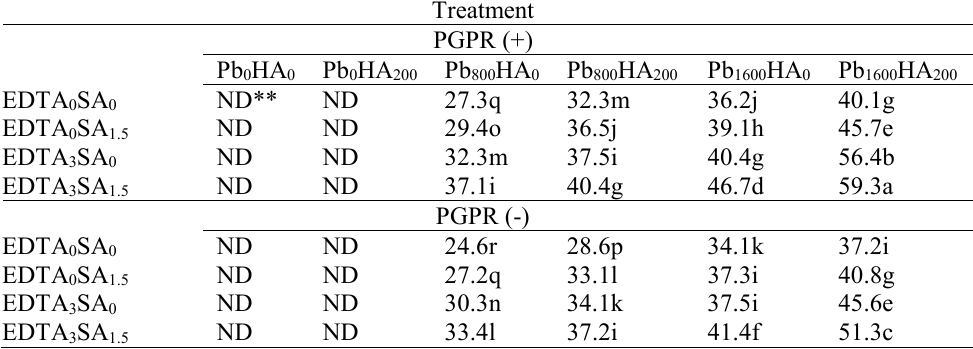
Table 4. Effect of treatments on plant Pb concentration (mg/kg)